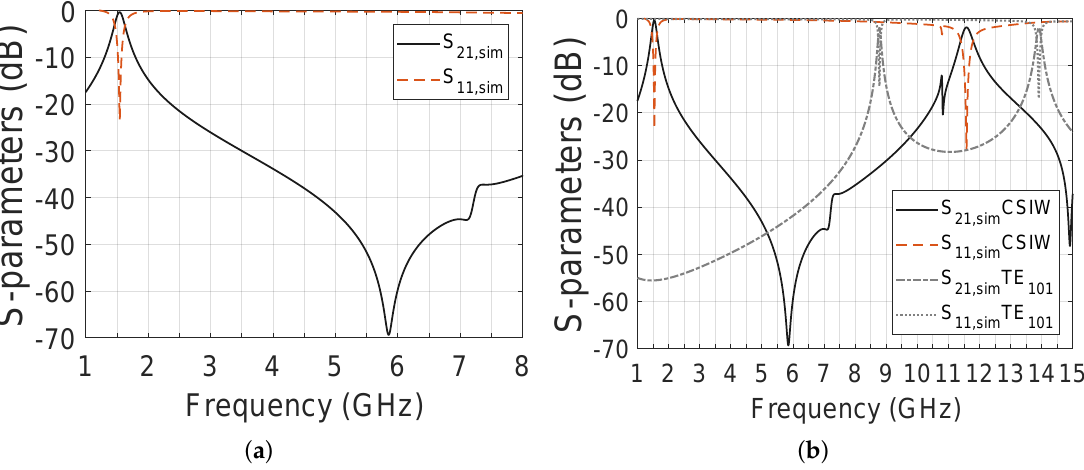
Figure 3. Simulated wideband response of ( a ) the proposed CSIW resonator having b = 105.5 mS; ( b ) Comparison between the frequency response of the proposed CSIW resonator (solid lines) and a standard TE 101 -based SIW resonator (dashed lines) having the same cavity size.